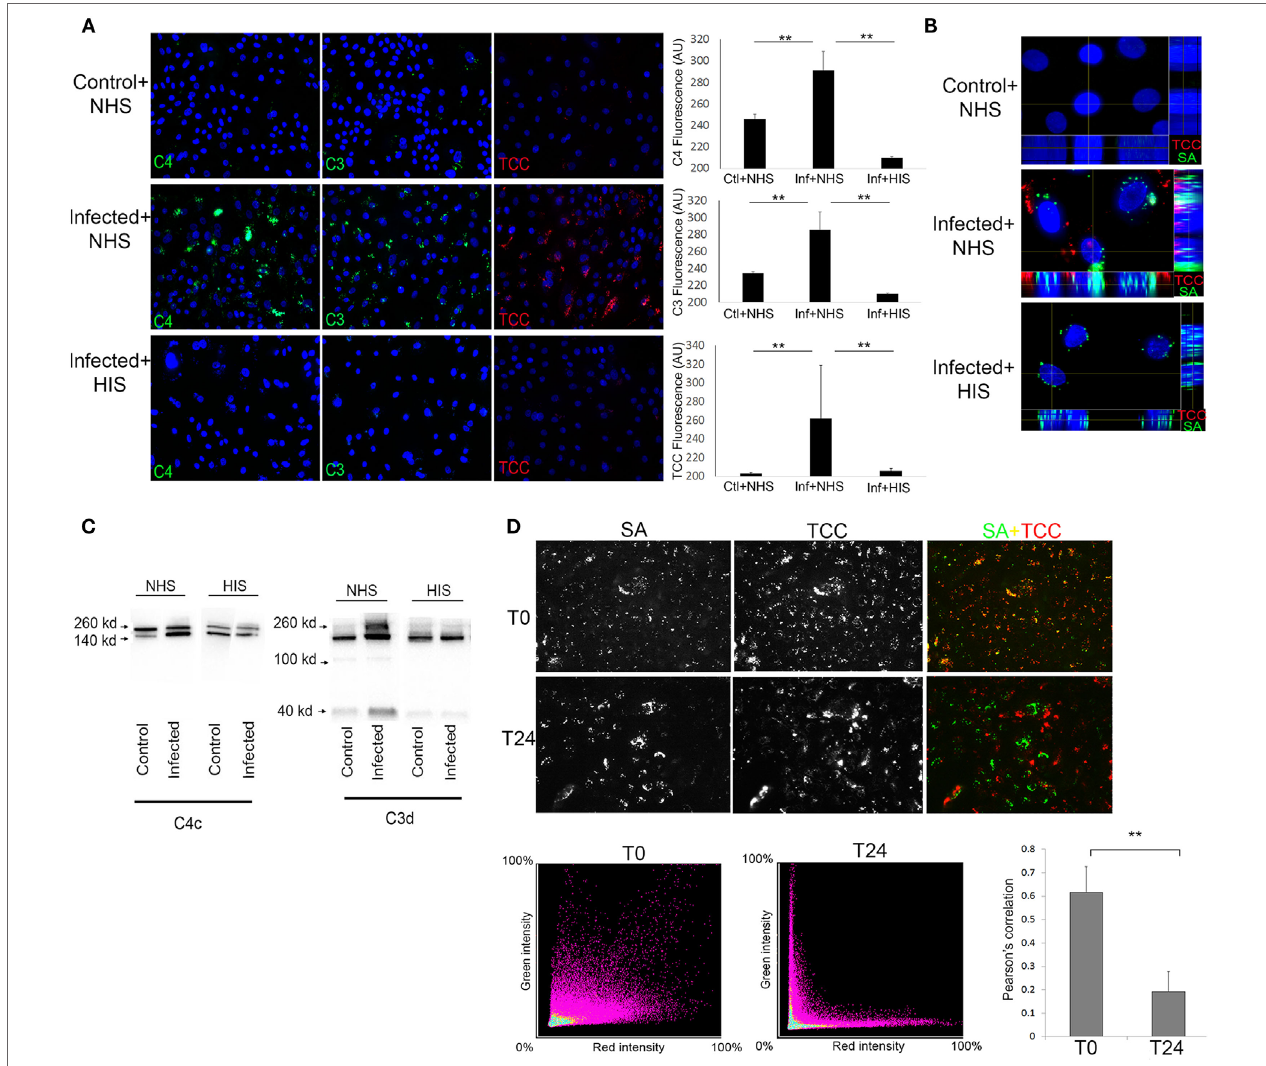
FigUre 2 | Keratinocytes with persistent intracellular Staphylococcus aureus (SA) activate the complement system on the cell surface. Immunofluorescence (IF) microscopy of primary keratinocytes infected with intracellular SA. (a) Keratinocytes were stained for complement activation fragments component 4 (C4), component 3 (C3), and terminal complement complex (TCC) using normal human serum (NHS) or HIS as a source of complement, IF was quantified in the panel to the right. (B) Orthogonal view of Z-stacks of keratinocytes infected with intracellular SA (green) show deposition of TCC (red) when incubated with NHS but not HIS. (c) New medium was added to the cells after complement activation and collected after 24 h to monitor release of activation fragments deposited on cells, Western blots show higher signal of C3 and C4 degradation products in media of infected cells treated with NHS. (D) Keratinocytes with intracellular SA present immediately after infection (T0) or persistent intracellular SA (T24) were incubated with NHS, colocalization (yellow) of SA (green) and TCC (red) indicates complement deposition on extracellular SA, colocalization was quantified over three experiments and represented using Pearson’s correlation coefficient in the bar graph in the lower right